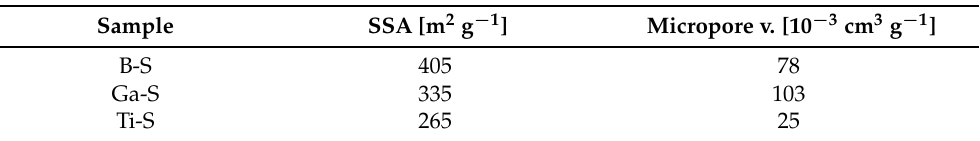
Table 1. Specific BET surface area (SSA) and micropore volume of the B-, Ga- and Ti-silicalite samples in the H +